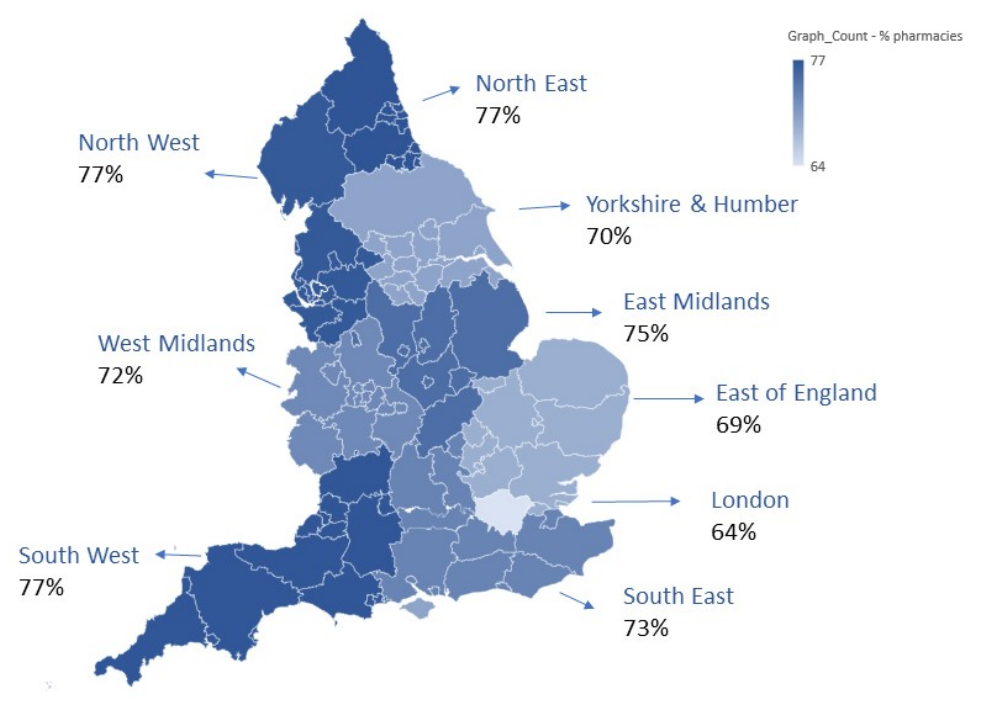
Figure 1. Regional breakdown including proportion of pharmacies who submitted data, as a per- centage of all pharmacies in each England region. The colour grade indicates the lowest to highest proportions of pharmacies. Table 2. Summary of the numbers of TARGET Antibiotic Checklists submitted by participating pharmacies.